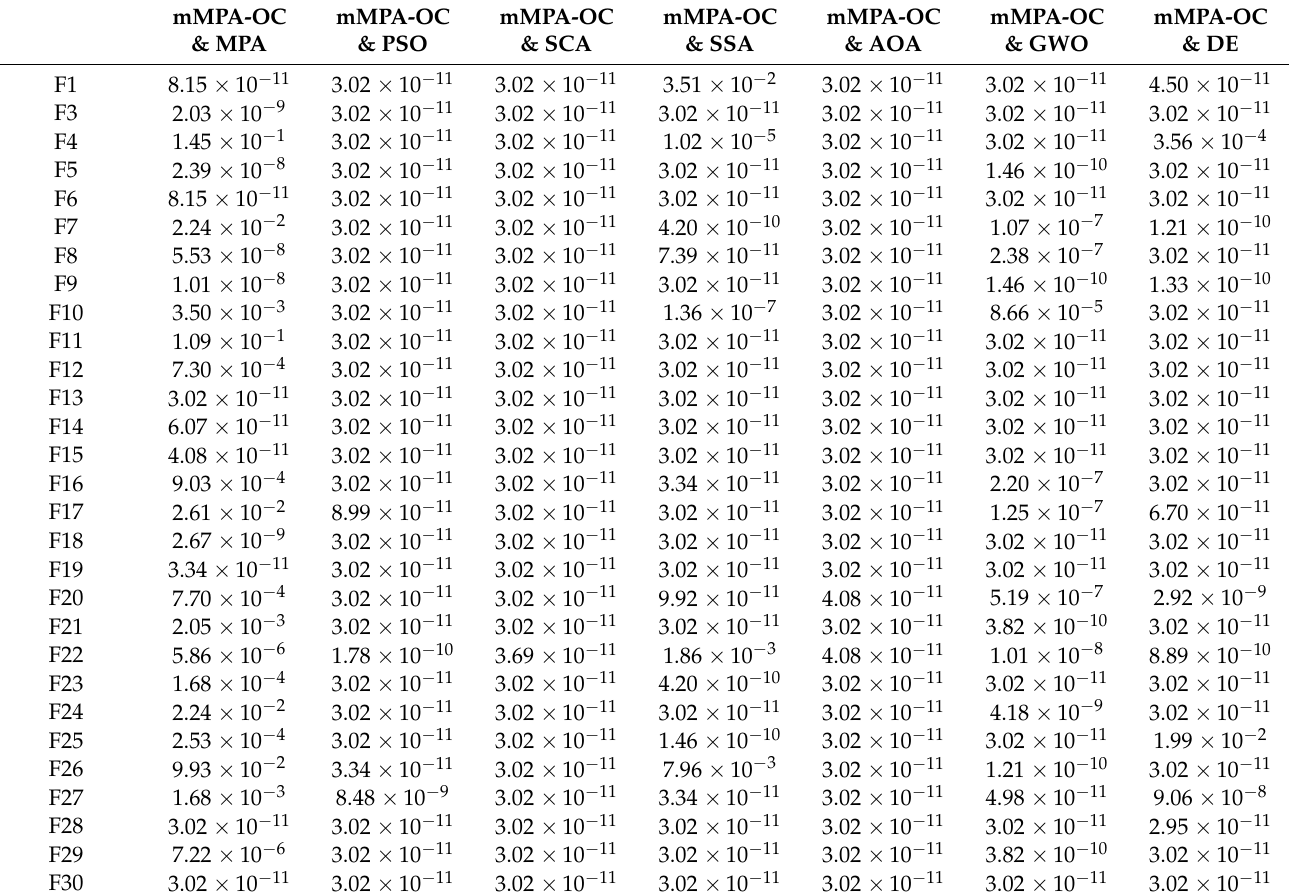
Table 13. p -values of the Wilcoxon rank sum test of mMPA-OC and the comparison algorithm in CEC-2017 (30 dimensions).